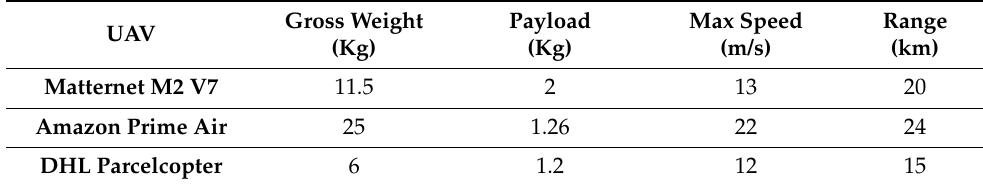
Table 2. Relevant features of delivery